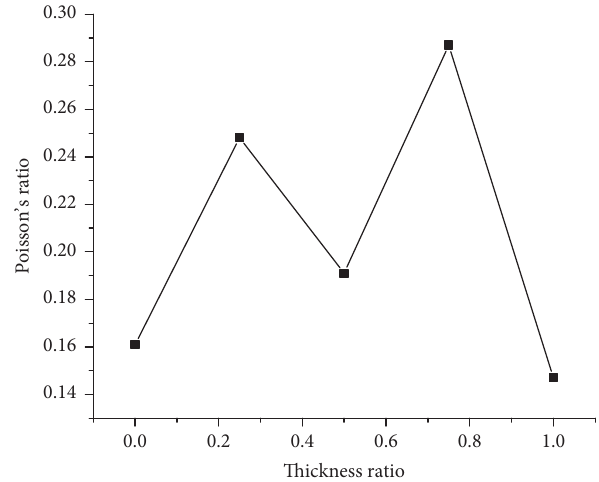
Figure 7: Effect of thickness ratio of high-strength materials on Poisson’s ratio of